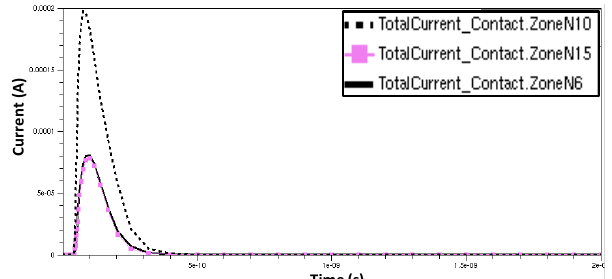
Fig. 15. 5x3 matrix (15 contacts). Comparison of the currents of the three highest currents (N10, N15, N6 contacts) for the alpha particle.